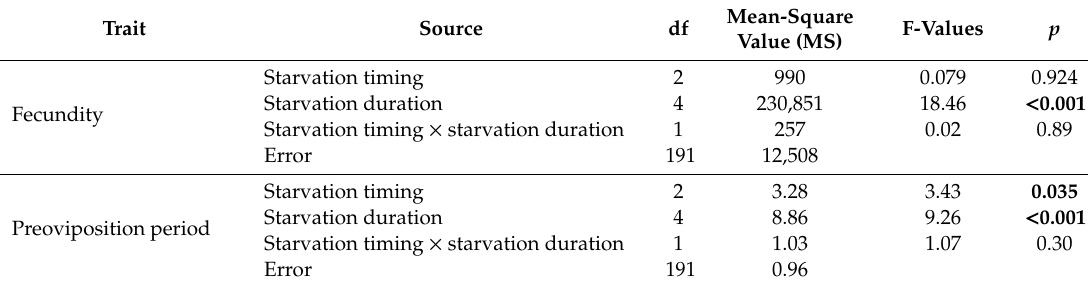
Table 1. Two-way ANOVA for the e ff ects of duration and timing of starvation on fecundity and preoviposition period in female Cnaphalocrocis medinalis . Trait Source df